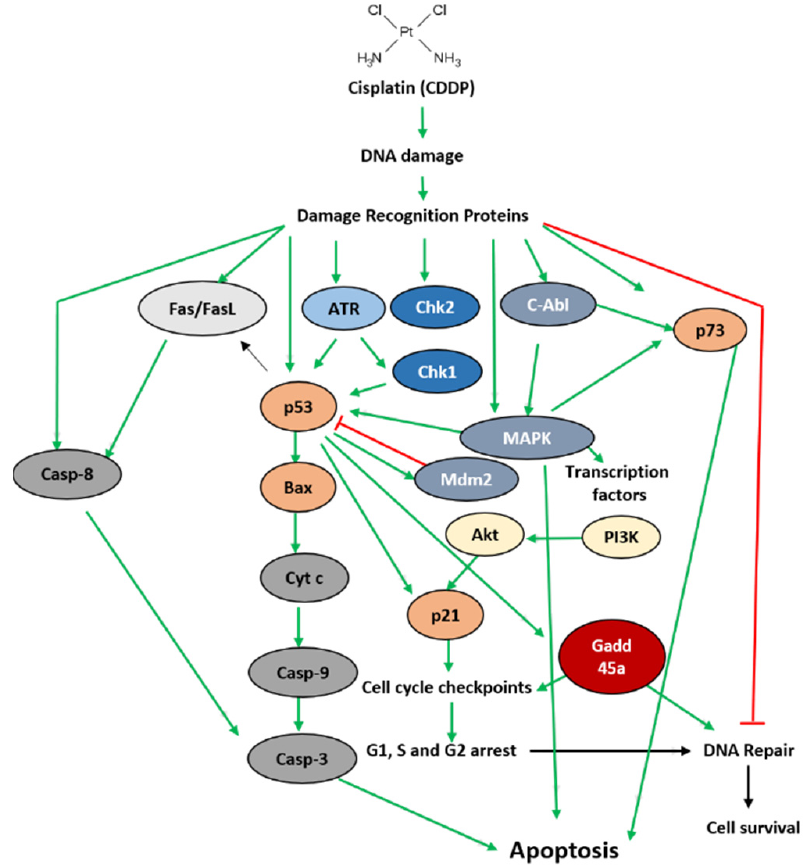
Figure 1. A brief overview of the pathways involved in mediating cisplatin-induced effects in cells. Apoptosis as well as cell survival depend on the nature and intensity of the signals generated and the crosslinks between the pathways involved. Apoptosis is initiated following the recognition of DNA damage by candidate proteins that bind to physical distortions in the DNA induced by cisplatin. When DNA damage is detected and cannot be repaired, the activation of the irreversible intrinsic death pathway mediated by p53 occurs. Depending on the intensity of DNA damage, the cell cycle is arrested at checkpoints that prevent its progression for DNA repair and cell survival. Ab-